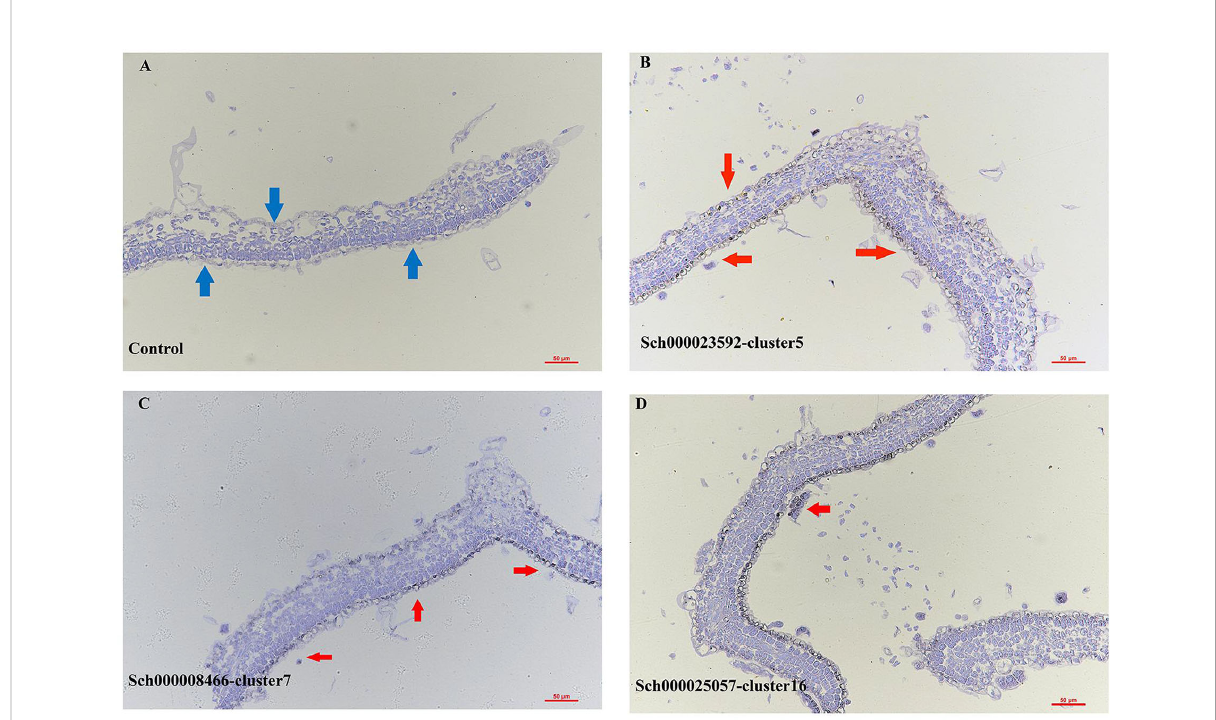
FIGURE 2 RNA in situ hybridization assays of control (A) , cluster 5 (Sch000023592, B ), cluster 7 (Sch000008466, C ) and 16 (Sch000025057, D ), The bule arrow was the epidermis of the control, the red arrow was the hybridization signal of the epidermis. The black indicated the location of the signal and blue were the